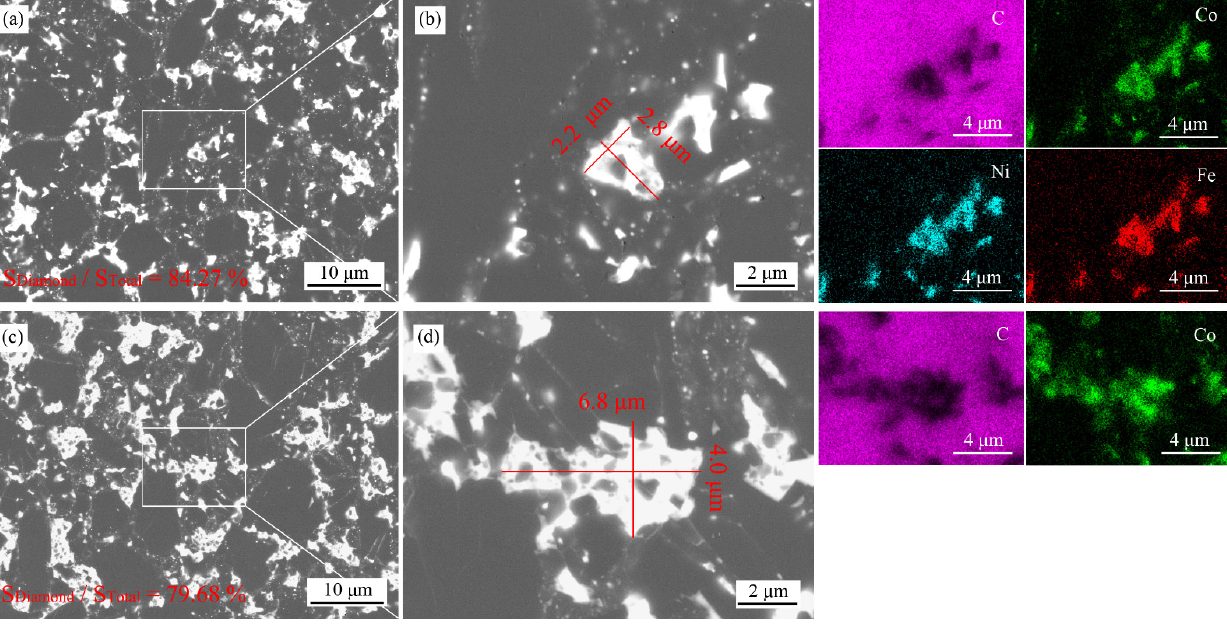
Figure 3. Microstructures, magnified image of metallic cluster and the elemental distributions of Co 50 Ni 40 Fe 10 -PCD ( a , b ) and Co-PCD ( c , d ).